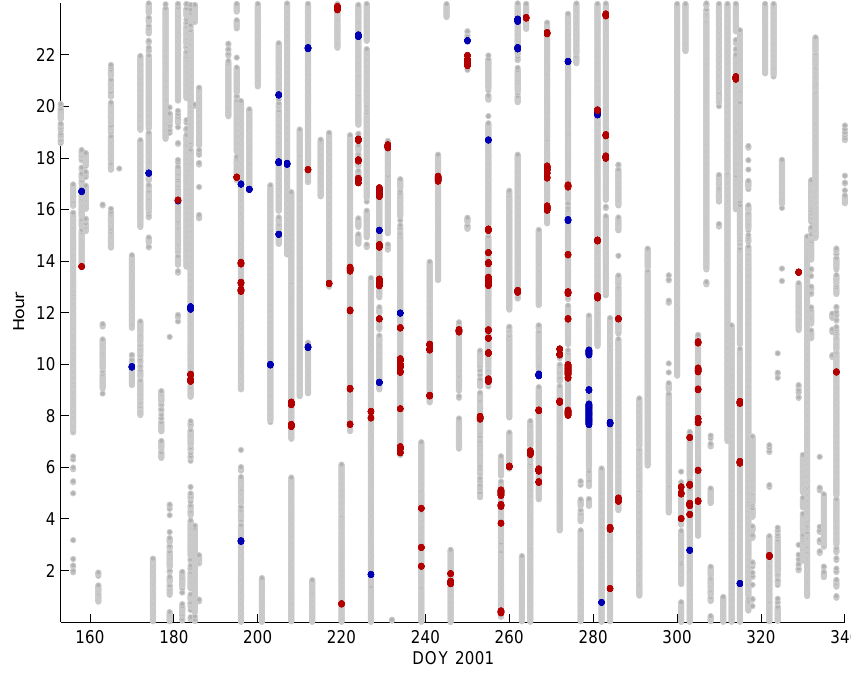
Fig. 4. Hour-DOY (Day Of Year) plot of the coverage of the Cluster plasma sheet data used in this investigation (grey lines). The red and blue dots indicate the CLRs and CGRs, respectively, observed by the mission. We note that the observed ECRs originate from several separate satellite orbits. Moreover, the time extent of many ECRs are rather short, of the order of about 1–10min (cf. H09B).